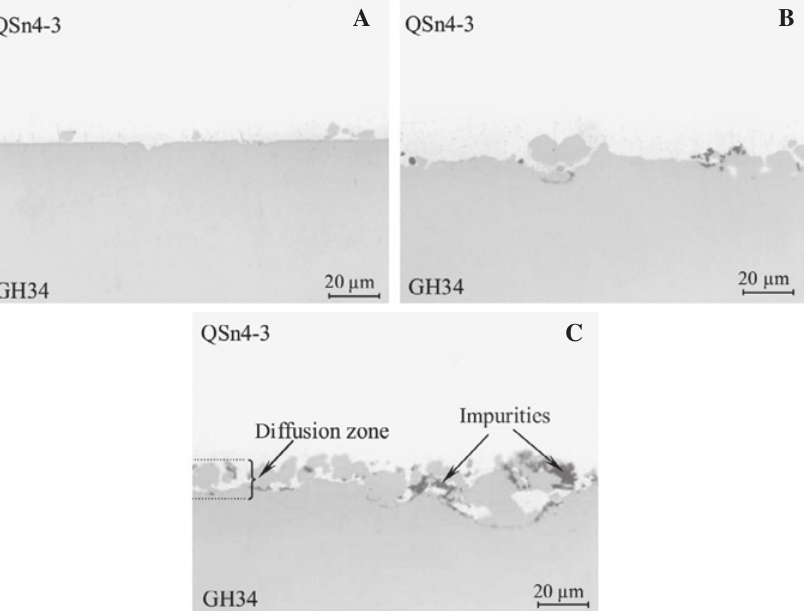
Figure 3 Interface microstructure of the joint bonded at 950 ° C, 10 MPa with a QSn6.5-0.1 interlayer for (A) 15 min, (B) 30 min and (C) 1 h.